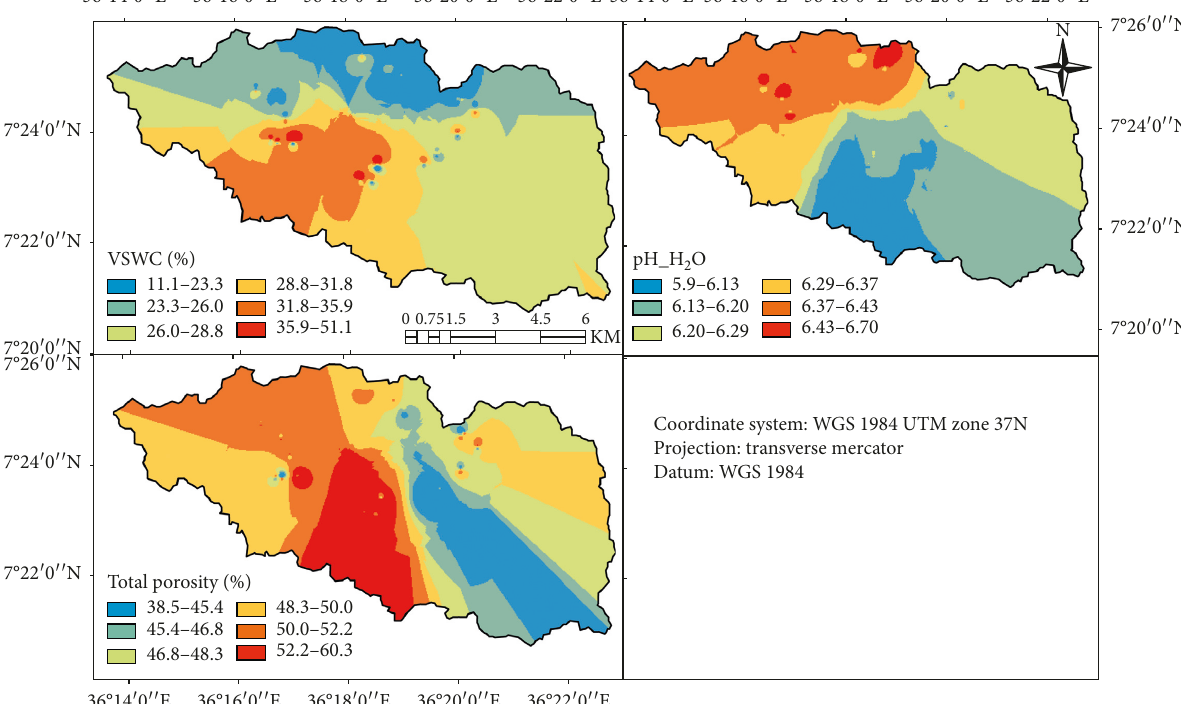
Figure 5: The map of spatial distribution of VSWC, TP, and soil pH in the Geshy